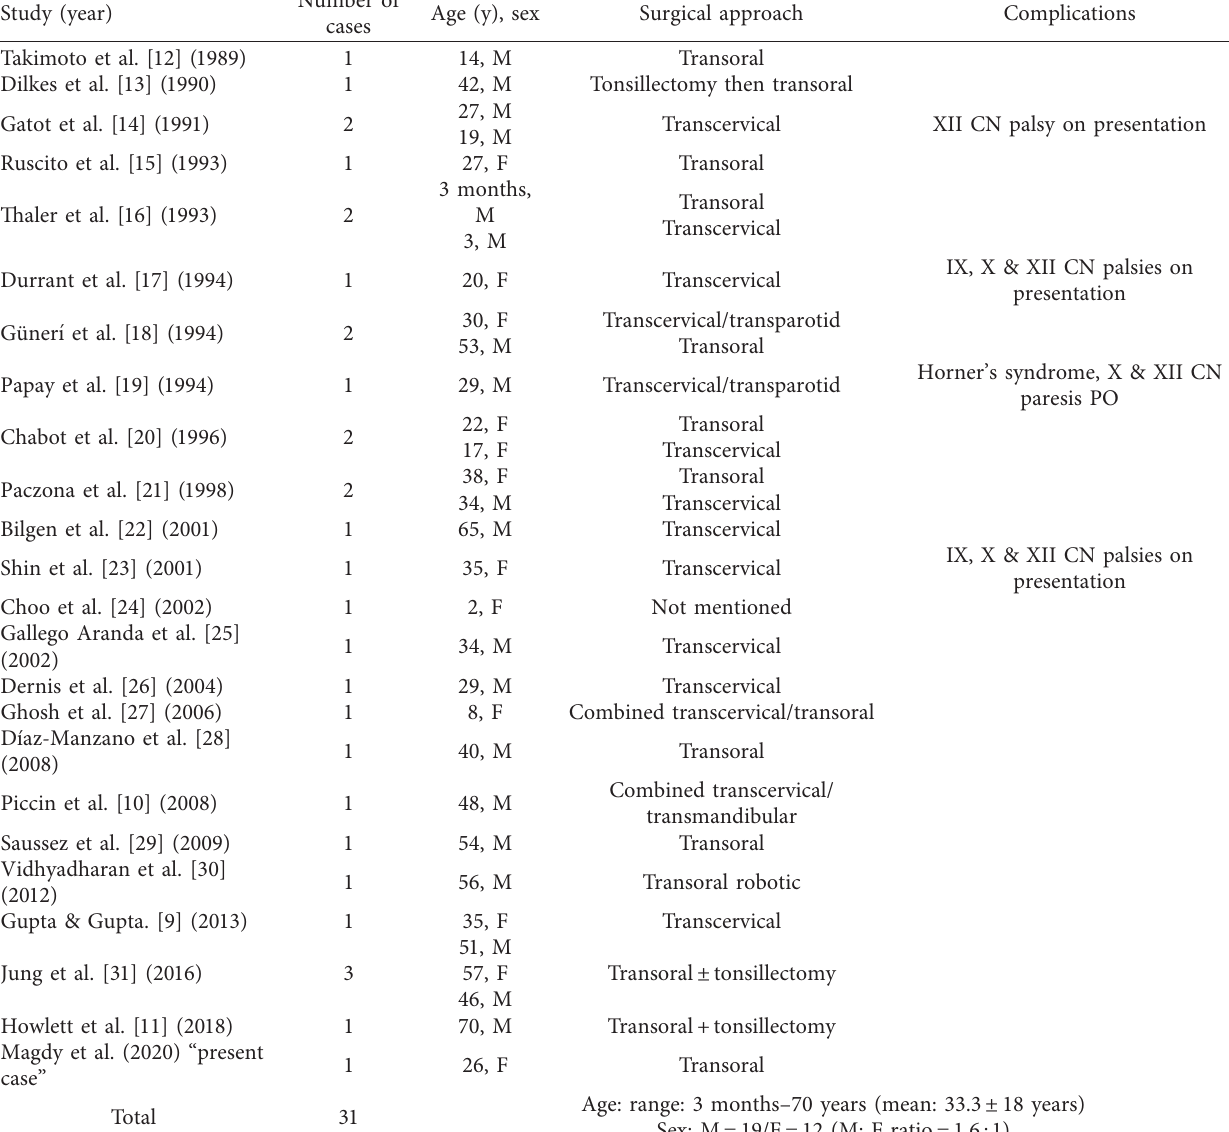
Table 1: Type-IV second BCC cases reported in the world literature (since